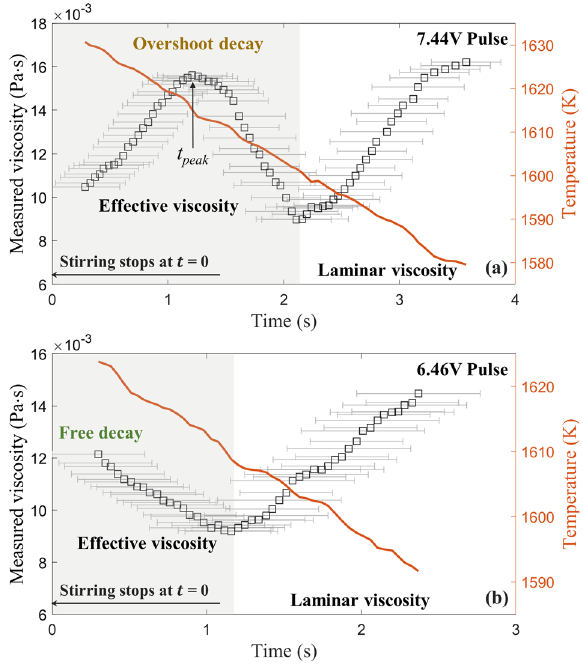
Fig. 1 Measured viscosities using the ISS-EML. The examples show the measured viscosities of a molten LEK-94 droplet as a function of elapsed time, superimposed with the decrease in temperature. a 7.44 V pulse. b 6.46 V pulse.